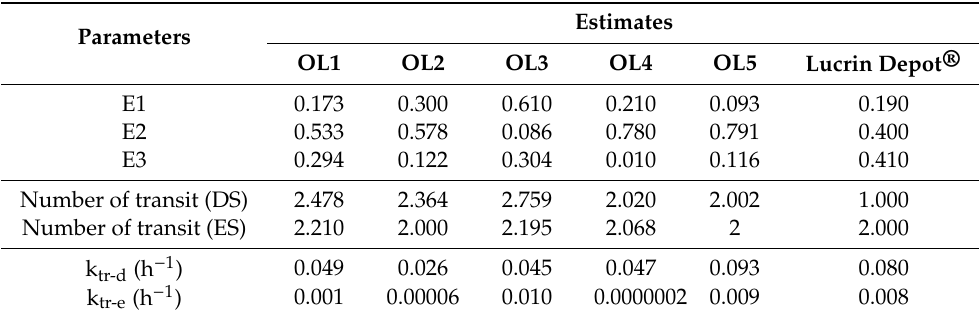
Table 2. Estimated parameters of the release compartment obtained by fitting the predicted in vivo release profile of electrosprayed microspheres.